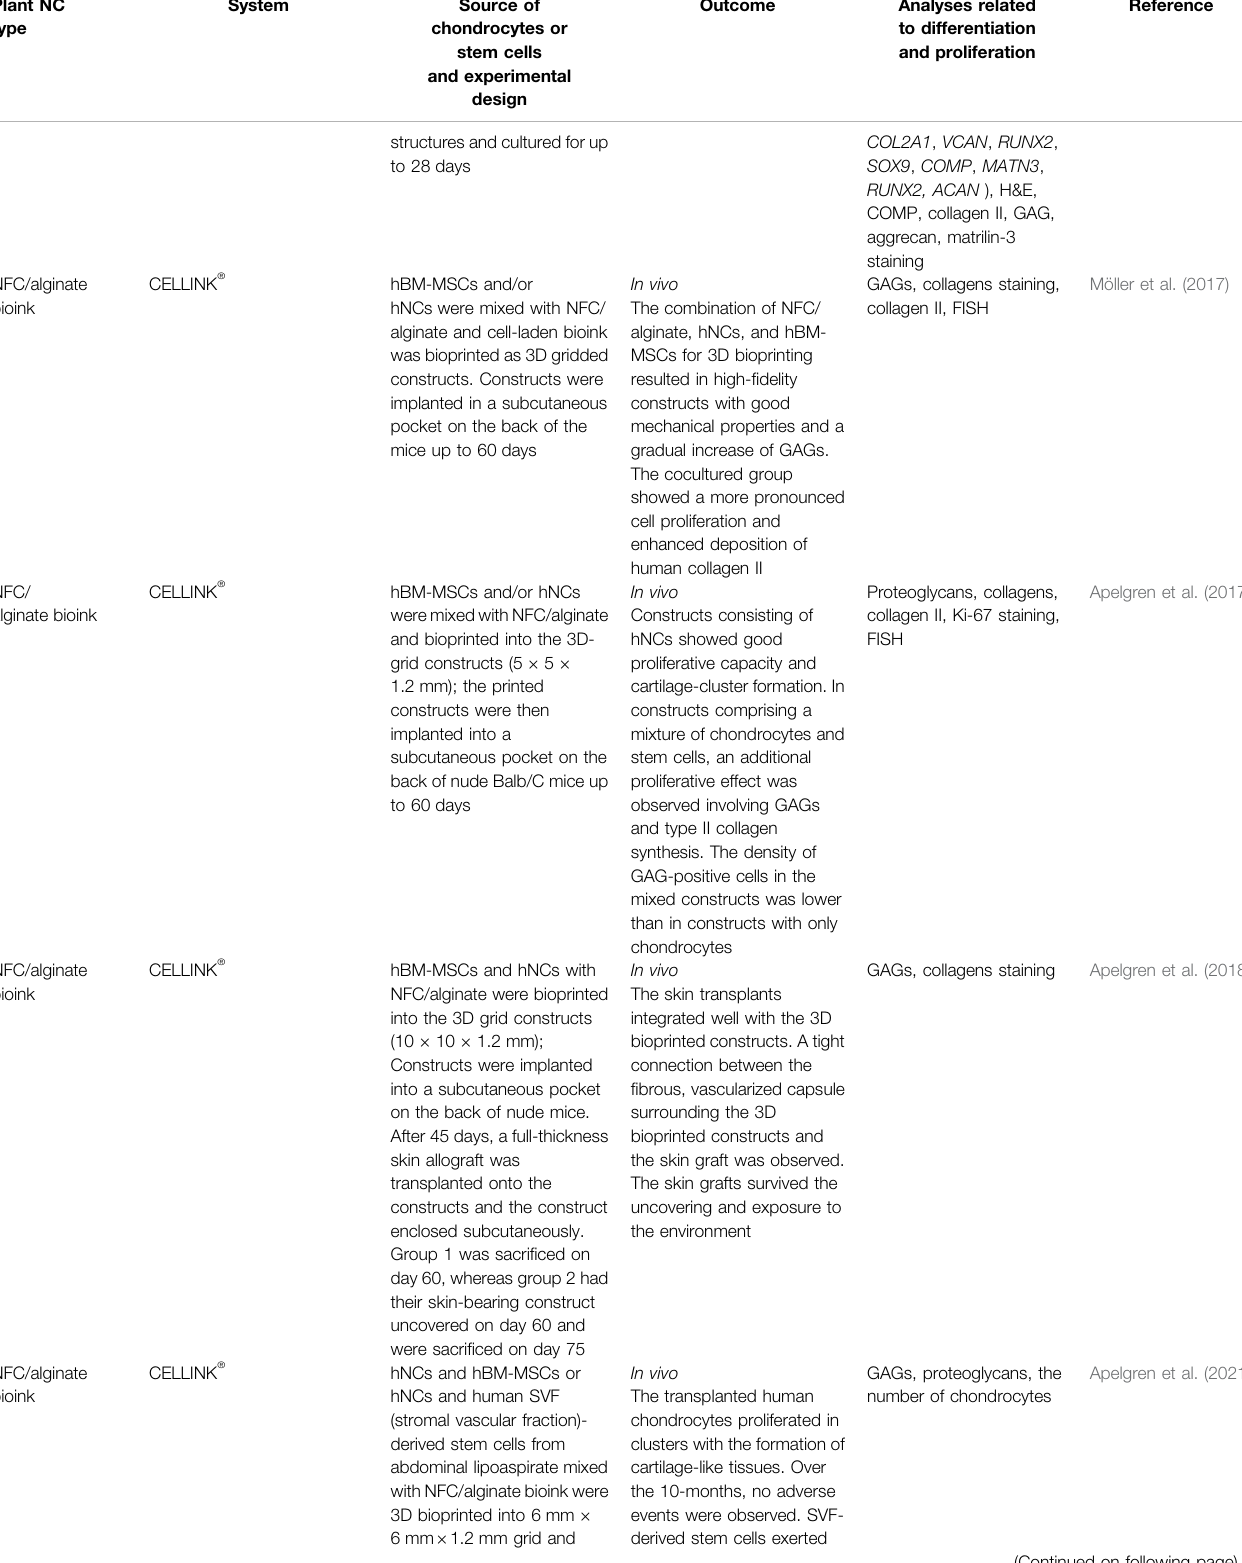
TABLE 1 | ( Continued ) Plant-derived NC applied to cartilage tissue